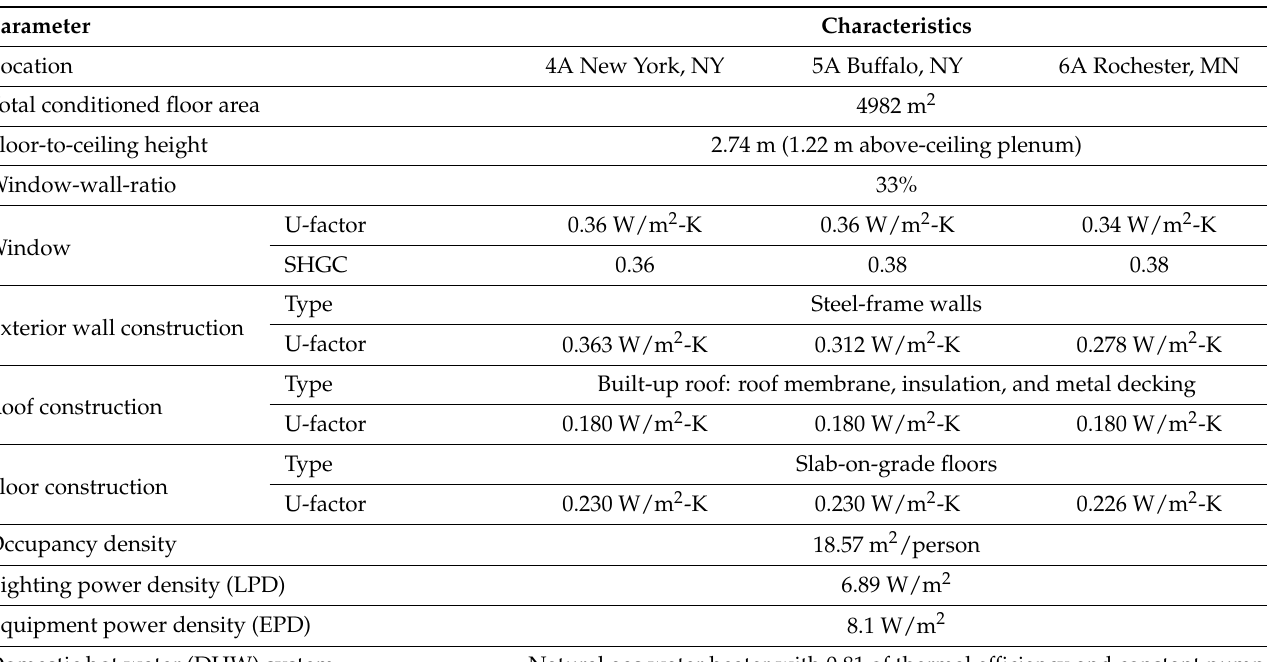
Table 2. Representative input parameter of the medium-sized office model [22,27].